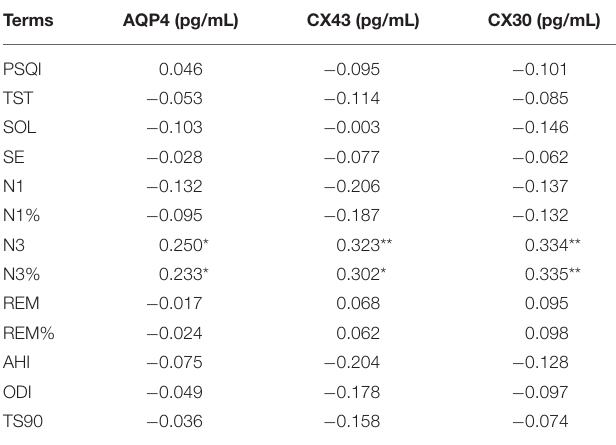
TABLE 4 | Partial correlation analysis between AQP4/CX43/CX30 and sleep